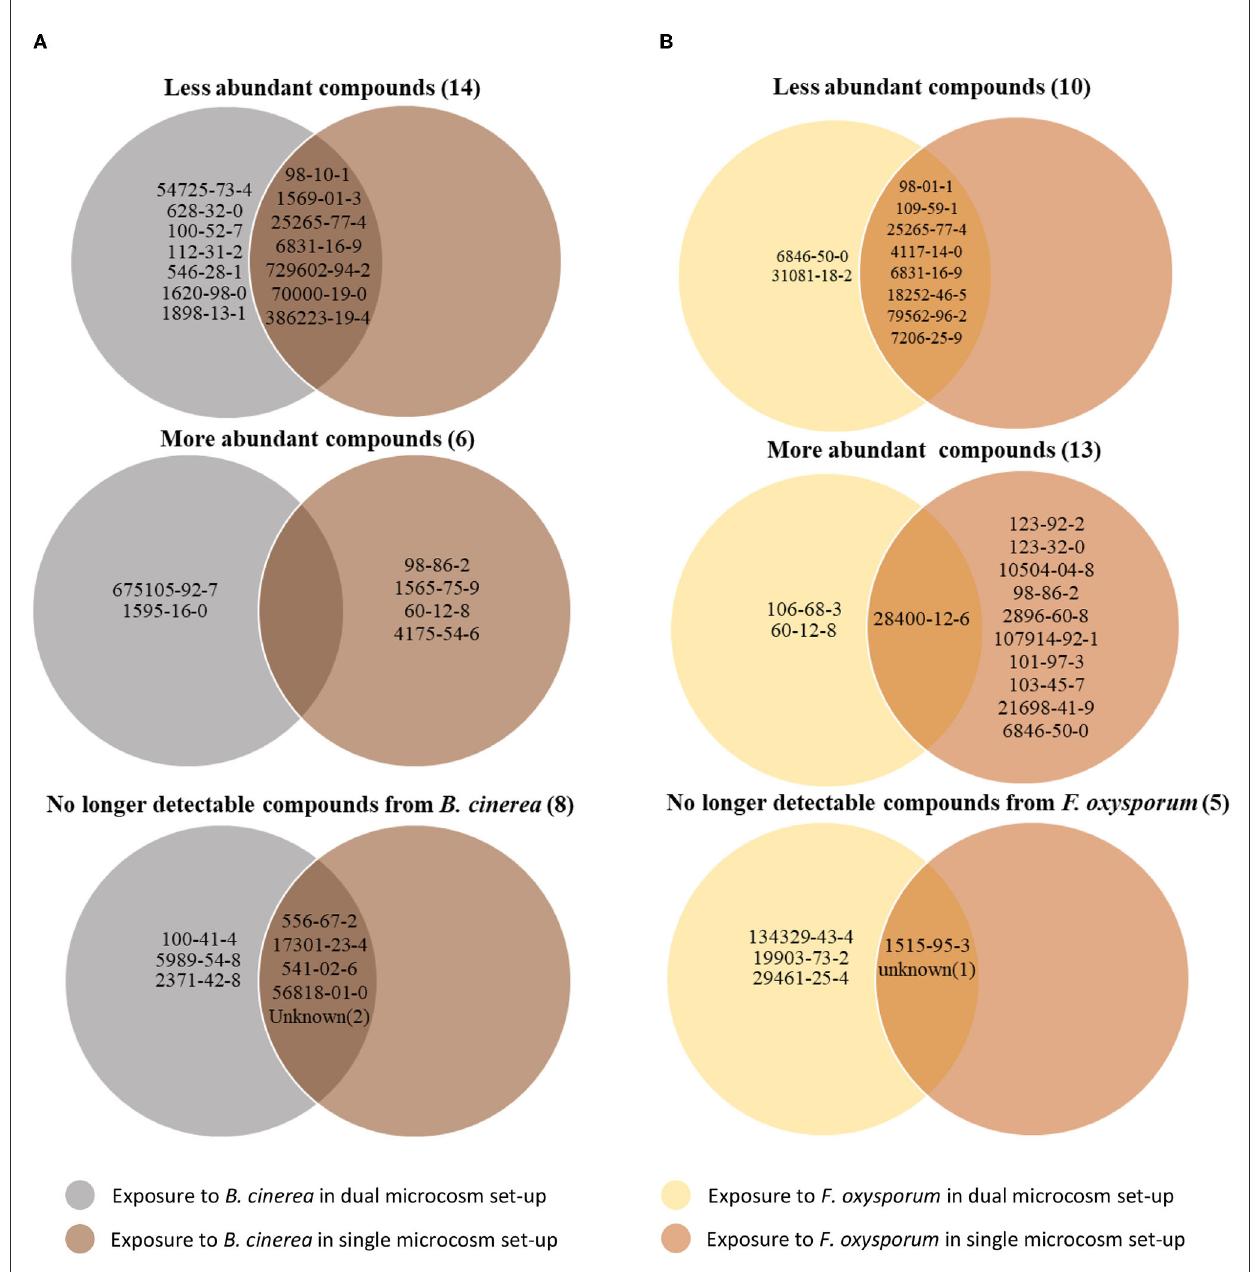
FIGURE5 Trichoderma volatile modifications after exposure to Botrytis or Fusarium volatilomes using the two different microcosm systems. For each interaction pattern, the Venn diagram displays the CAS number of compounds with significantly modified abundance after exposure of Trichoderma to Botrytis (A) or Fusarium (B) volatiles diluted in methanol or directly emitted from another